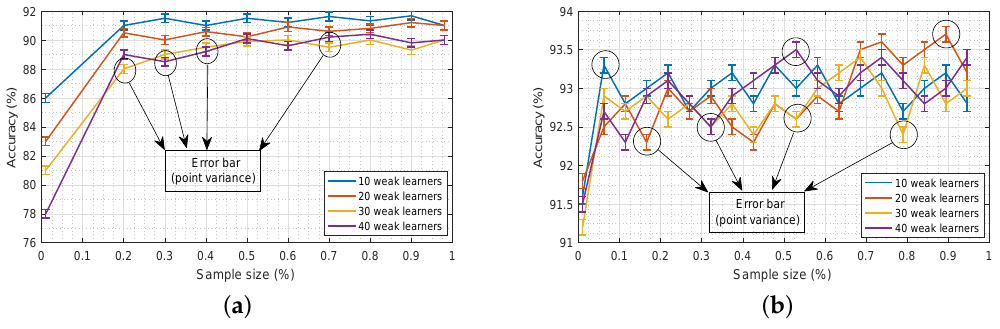
Figure 5. Accuracy vs. sampling size for different numbers of weak learners: ( a ) bagging of test set for Training Set 1, ( b ) bagging of test set for Training set 2.